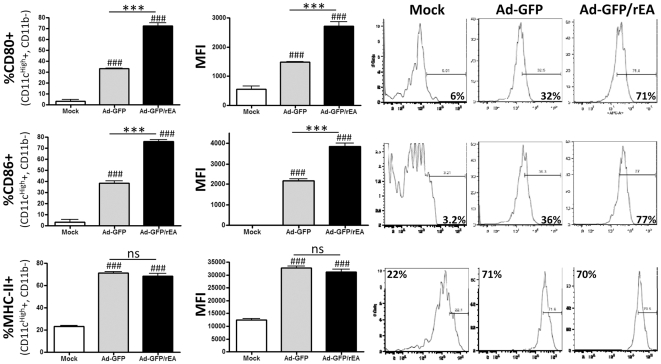
Ad-GFP and Ad-GFP/rEA induced DC activation in spleen in vivo.C57BL/6 mice (N = 3) were either mock injected or injected with 7.5×1010 vps of either Ad-GFP or Ad-GFP/rEA. Lymphocytes from spleen tissue were harvested at 6 hpi, stained for expression of surface markers Cd11c, Cd11b, CD80, CD86 and MHC-II. CD-19, NK1.1, and CD3 expressing cells were eliminated using PerCP-Cy5.5 labeled antibodies. Cd11cHigh, Cd11b- cells are represented. Bars represent mean ± SE. #, ##, ### represent significantly different from mock injected mice (p<0.05, p<0.01, p<0.001 respectively). *,**,*** represent statistical differences (p<0.05, p<0.01, p<0.001, respectively). Representative histograms are found at right. ns, not significant; MFI, mean fluorescence intensity.